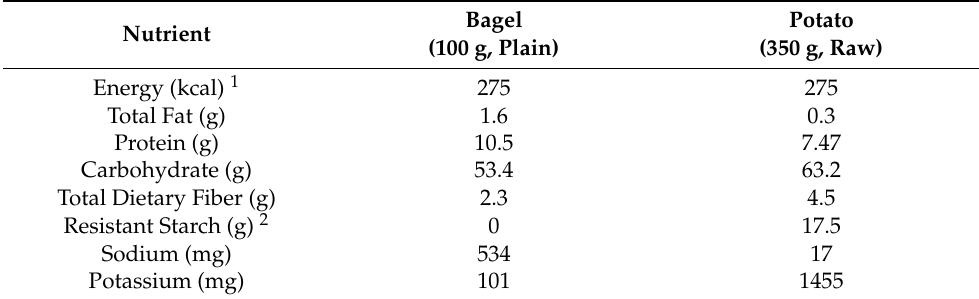
Table 1. Energy and select nutrient content of potato and